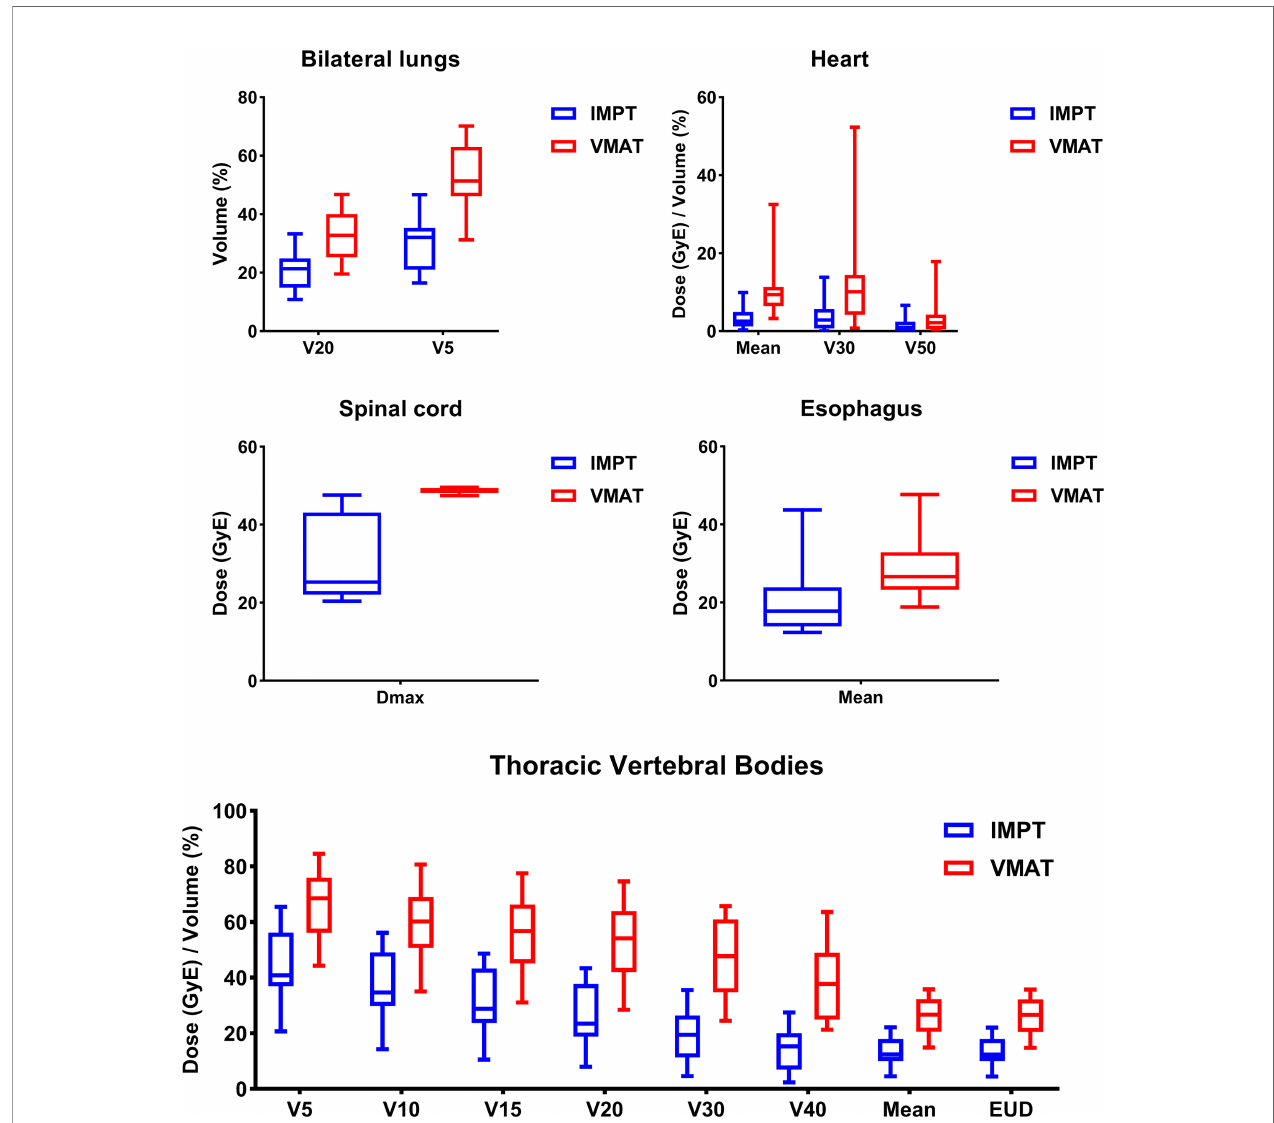
FIGURE 3 | Dosimetric results of the subgroup patients with tumor distance ≤ 0.7cm to thoracic vertebral